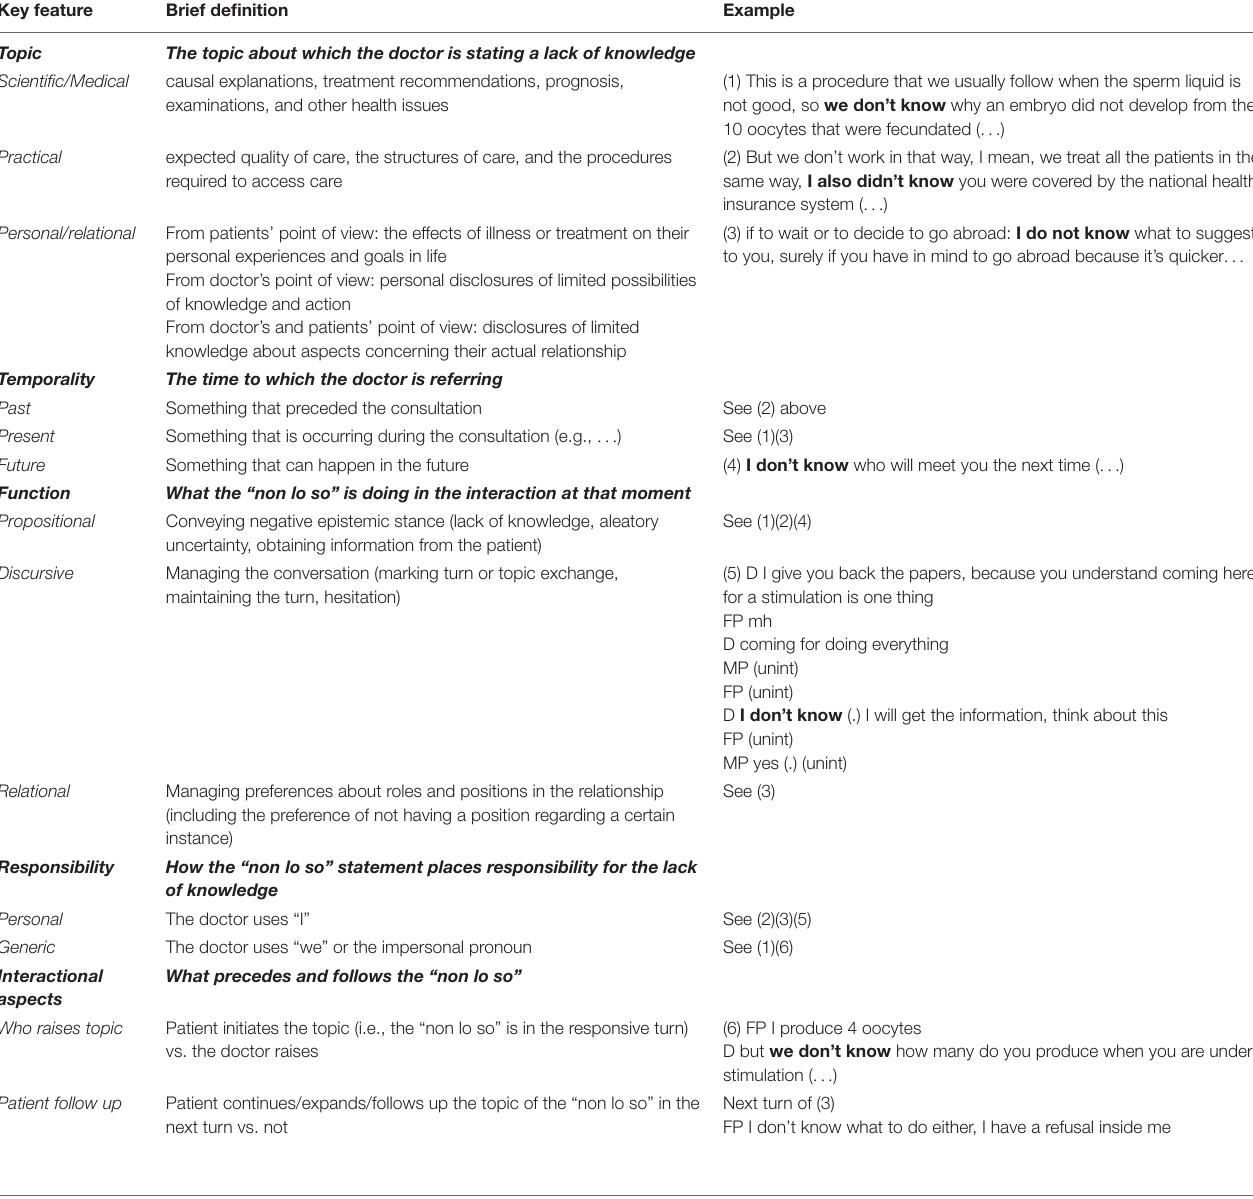
TABLE 1 | Key features of “non lo so” considered in the analysis, with definition and decontextualized